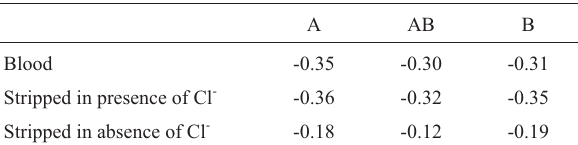
Table I - Bohr effect values ( φ ) of the three phenotypes in different experimental